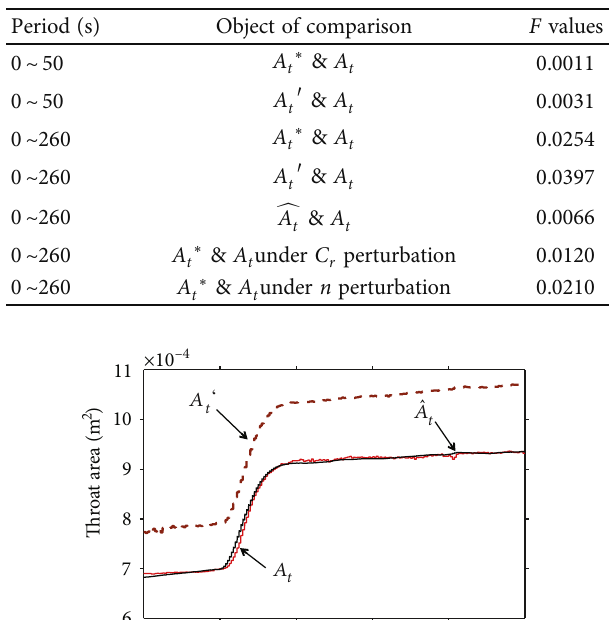
Figure 22: Estimation of throat area under various conditions. Table 1: The F values in each case.